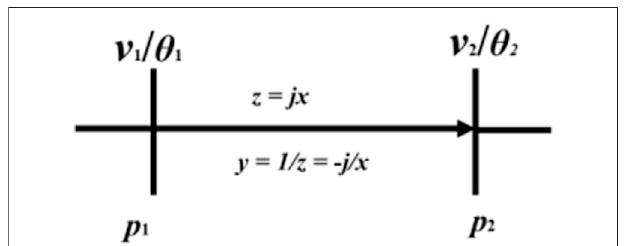
FIGURE A2 | DC transmission line